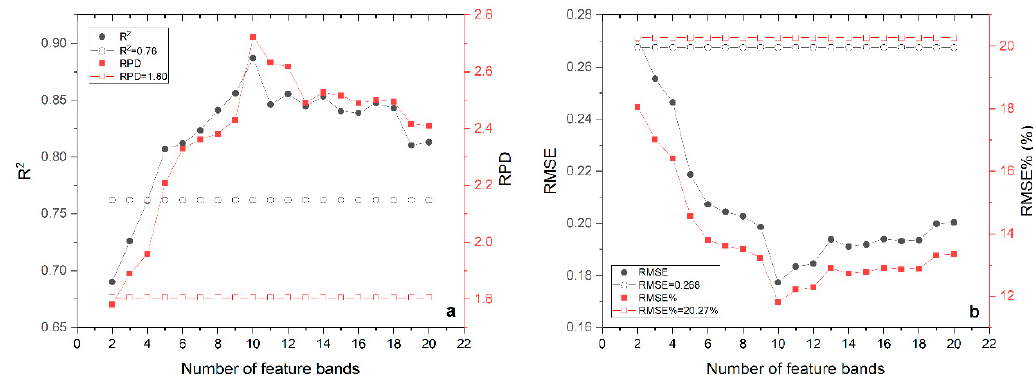
Figure 12. Sensitivity analysis. ( a ) The hollow line in the figure shows the result obtained by the RS–PLSR method; the black line indicates R 2 , and the red line indicates RPD. ( b ) The hollow line in the figure shows the result obtained by the RS–PLSR method; the black line indicates RMSE and the red line indicates RMSE%.